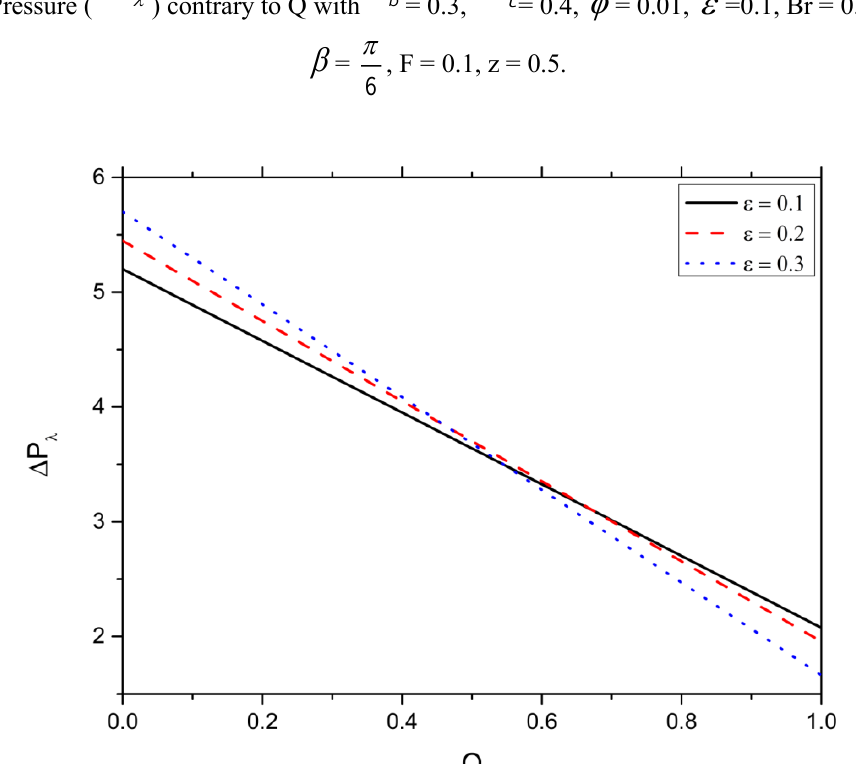
 P  ) contrary to Q with b